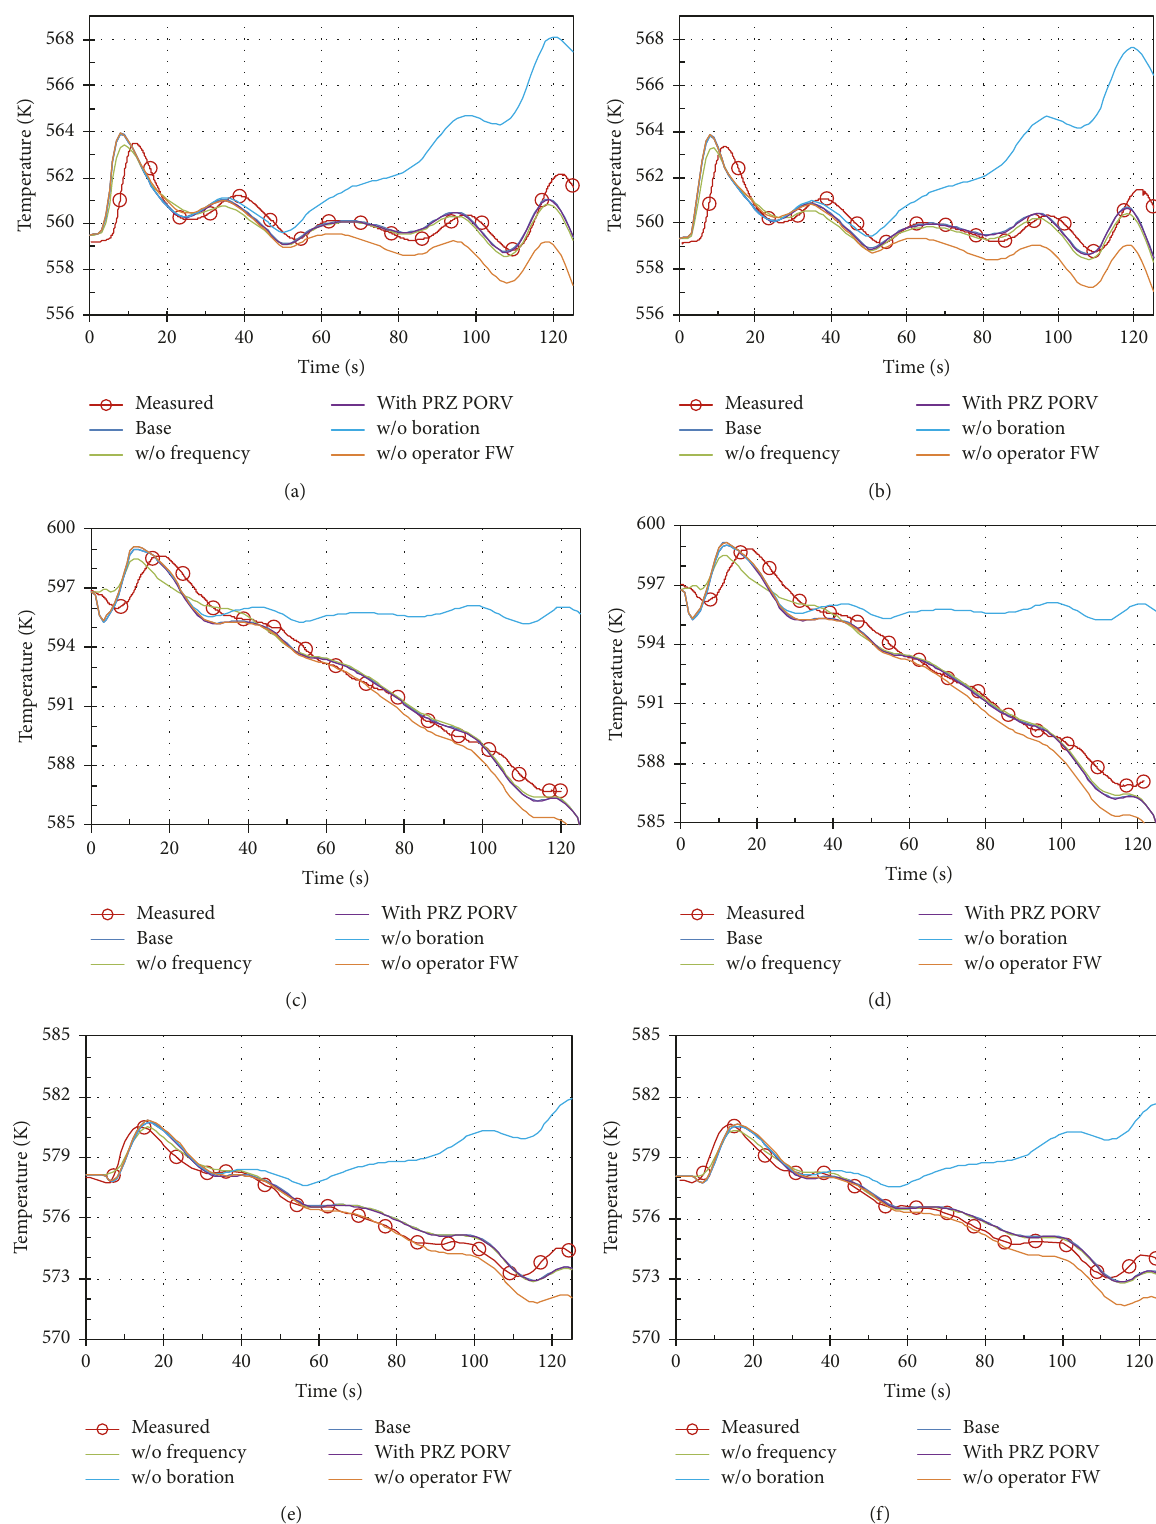
Figure 9: First part: (a) cold leg number 1 temperature; (b) cold leg number 2 temperature; (c) hot leg number 1 temperature; (d) hot leg number 2 temperature; (e) RCS loop number 1 average temperature; (f) RCS loop number 2 average